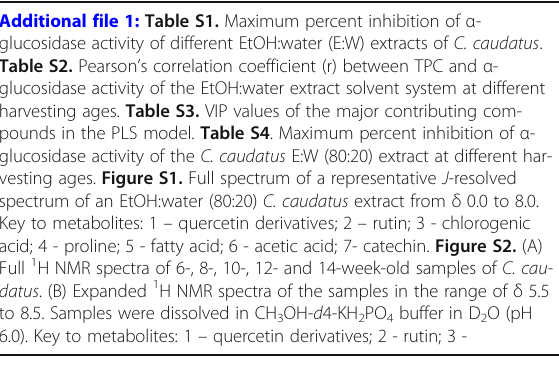
Table S2. Pearson ’ s correlation coefficient (r) between TPC and α - glucosidase activity of the EtOH:water extract solvent system at different harvesting ages. Table S3. VIP values of the major contributing com- pounds in the PLS model. Table S4 . Maximum percent inhibition of α - glucosidase activity of the C. caudatus E:W (80:20) extract at different har- vesting ages. Figure S1. Full spectrum of a representative J -resolved spectrum of an EtOH:water (80:20) C. caudatus extract from δ 0.0 to 8.0. Key to metabolites: 1 – quercetin derivatives; 2 – rutin; 3 - chlorogenic acid; 4 - proline; 5 - fatty acid; 6 - acetic acid; 7- catechin. Figure S2. (A) Full 1 H NMR spectra of 6-, 8-, 10-, 12- and 14-week-old samples of C. cau- datus . (B) Expanded 1 H NMR spectra of the samples in the range of δ 5.5 to 8.5. Samples were dissolved in CH 3 OH- d 4-KH 2 PO 4 buffer in D 2 O (pH 6.0). Key to metabolites: 1 – quercetin derivatives; 2 - rutin; 3 -